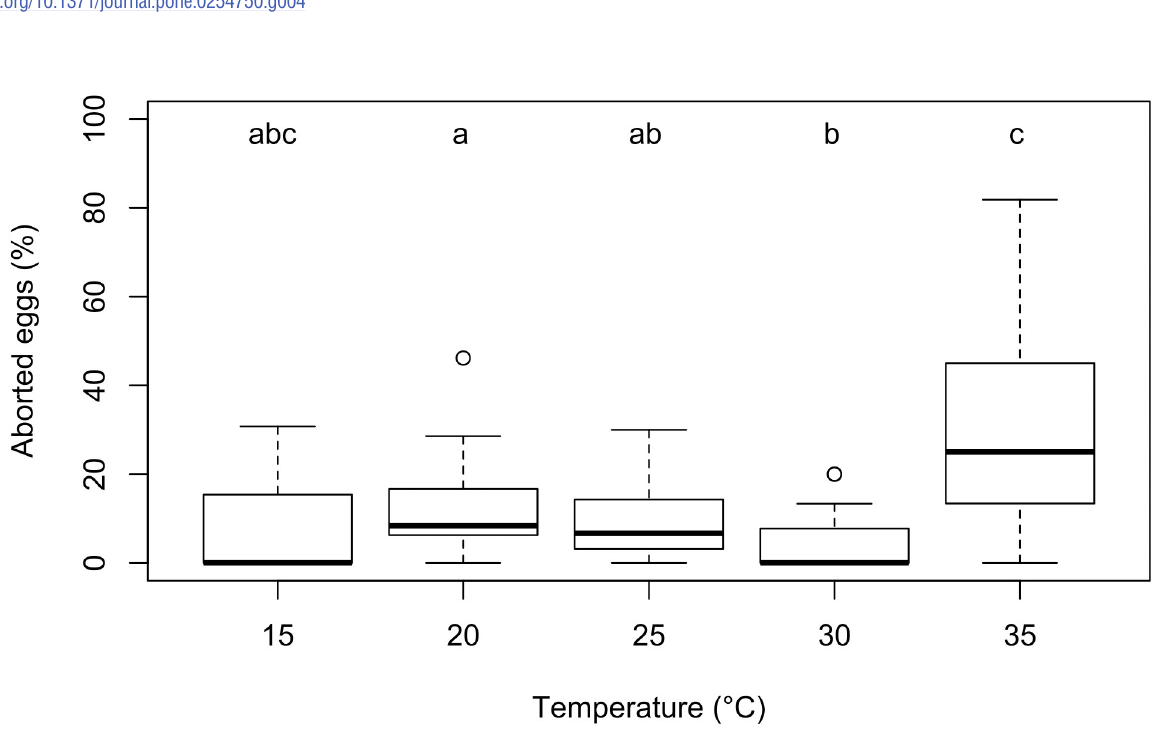
Fig 5. Percentage of Listronotus oregonensis aborted eggs in patches exploited by Anaphes listronoti females at different temperatures. Boxes represent the 25 th and 75 th percentiles, the heavy line represents the median, whiskers represent 1.5 × interquartile range of the data, and data points represent outliers. Different letters represent significant differences between temperatures.